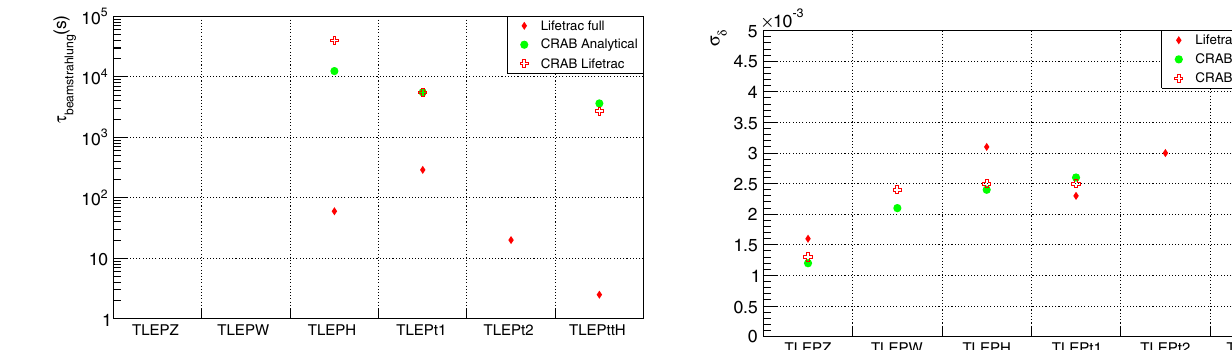
FIG. 9. Energy spread for different scenarios of TLEP oper- ation. Red diamonds and red empty crosses are L IFETRAC simulations with full spectrum of beamstrahlung for Tables I and II, correspondingly; green dots are analytical calculations for the latter